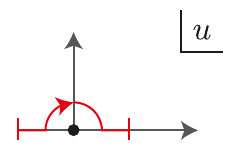
Figure 1 . Contour of the integral (A.7), which has a pole at u = (cid:0) i(cid:15)